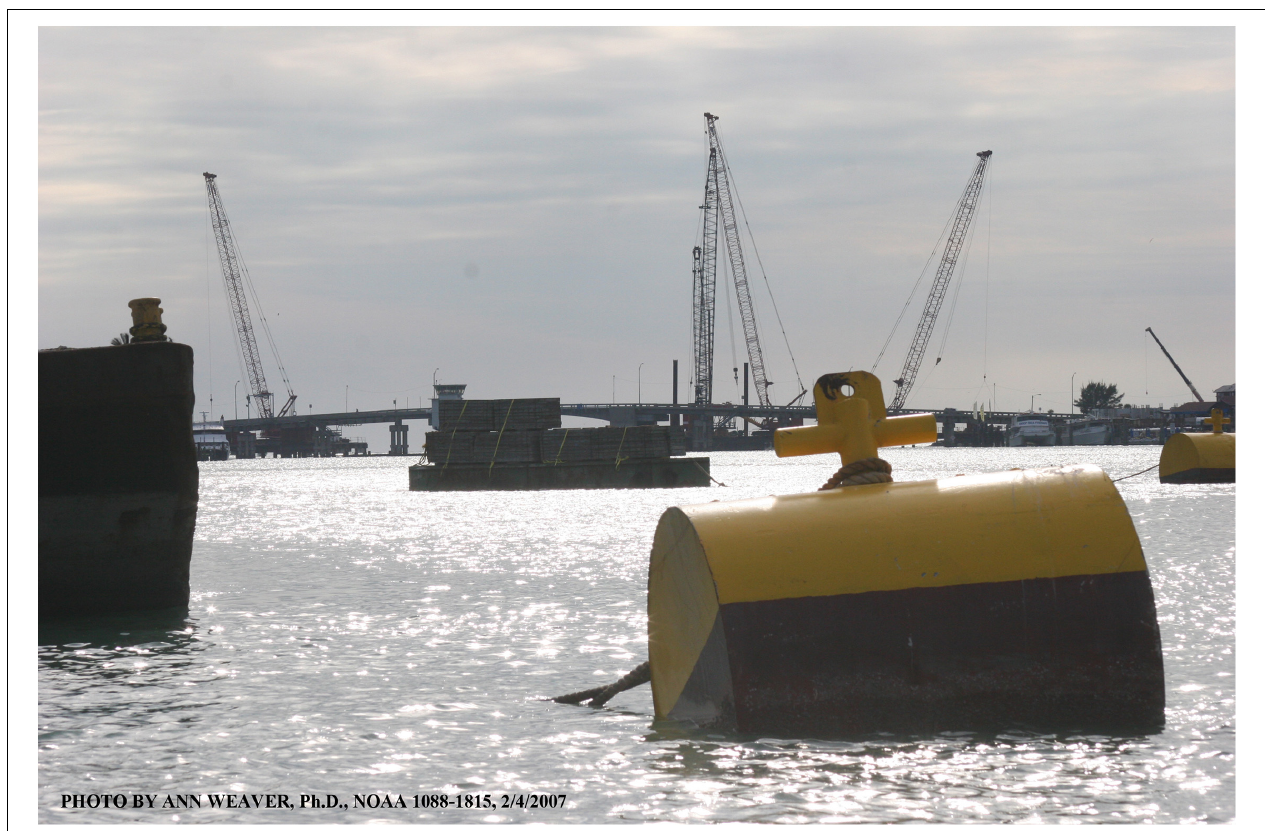
FIGURE 2 | View of the construction zone from the ICW. Construction activities occurred in two consecutive sets to maintain one lane open to vehicular traffic. The first set involved removing and replacing the Gulf or W lane of the bridge (January 2006 through approximately mid-summer 2008). The second set involved removing and replacing the ICW or E lane of the bridge (mid-summer 2008 through October 2010). Each step consecutively exposed the construction zone habitat to three sets of